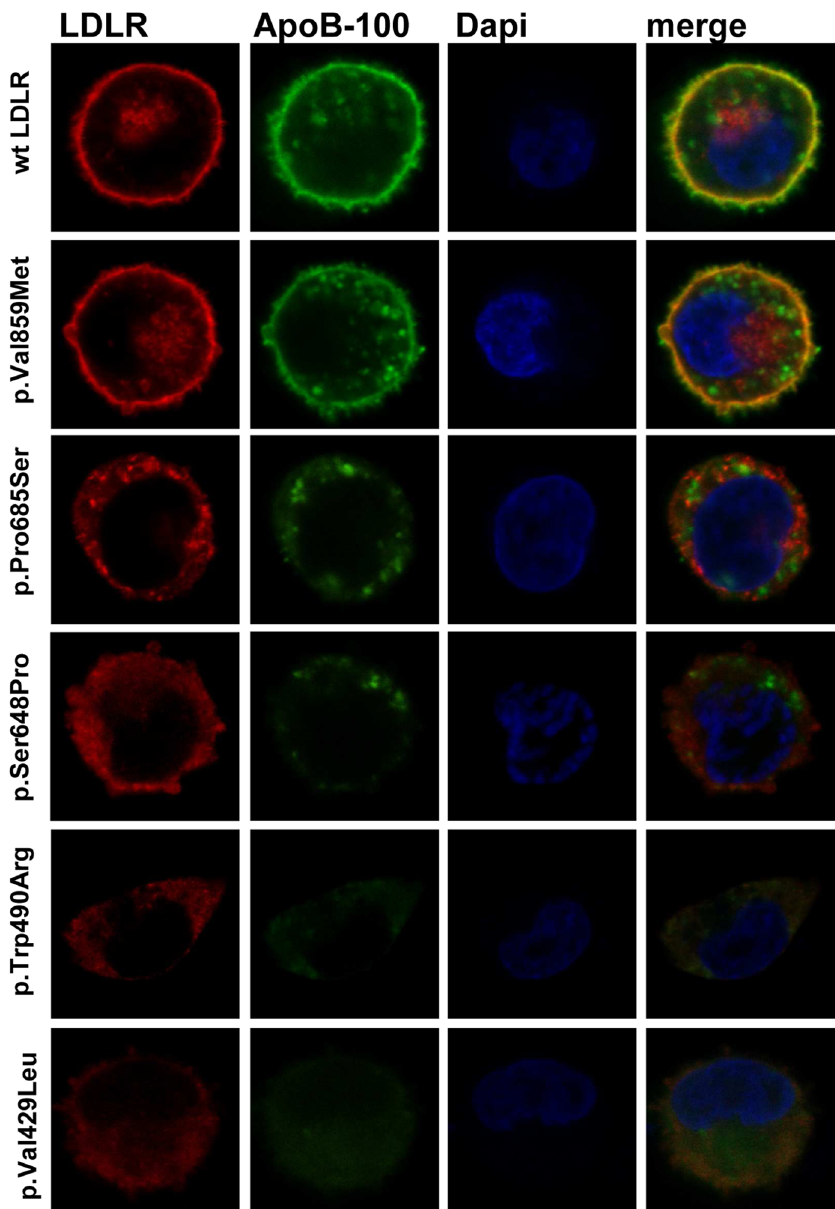
Figure 6. LDLR expression of the different variants at cell surface in CHO- ldlA7 transfected cells. For confocal analysis of LDLR at cellular membrane and LDL uptake, CHO- ldlA7 transfected cells were immunostained as described in Material and Methods with anti-hLDLR antibody and anti-ApoB100 antibody. Texas Red and Alexa Fluor 488 labeled secondary antibodies were used to visualize LDLR or LDL, respectively. Dapi was used to stain nuclei. The images show a representative individual